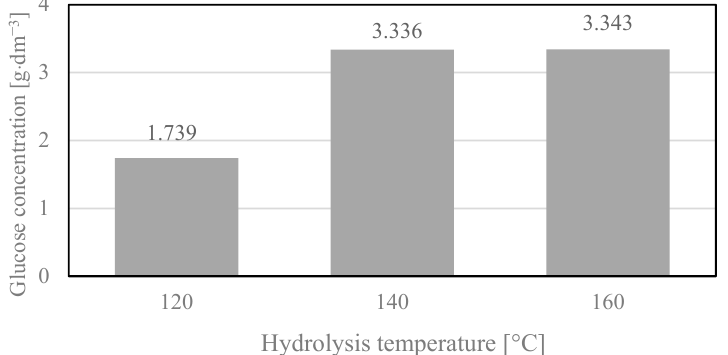
Figure 2. Glucose concentration in hydrolysates depending on the temperature of hydrolysis. Reaction conditions: 2 h, 2% H 2 SO 4 . Glucose concentrations were the arithmetic mean of the results obtained in the three hydrolysis processes with the standard deviations: 1.739 ± 0.157; 3.336 ± 0.167; 3.343 ± 0.137.